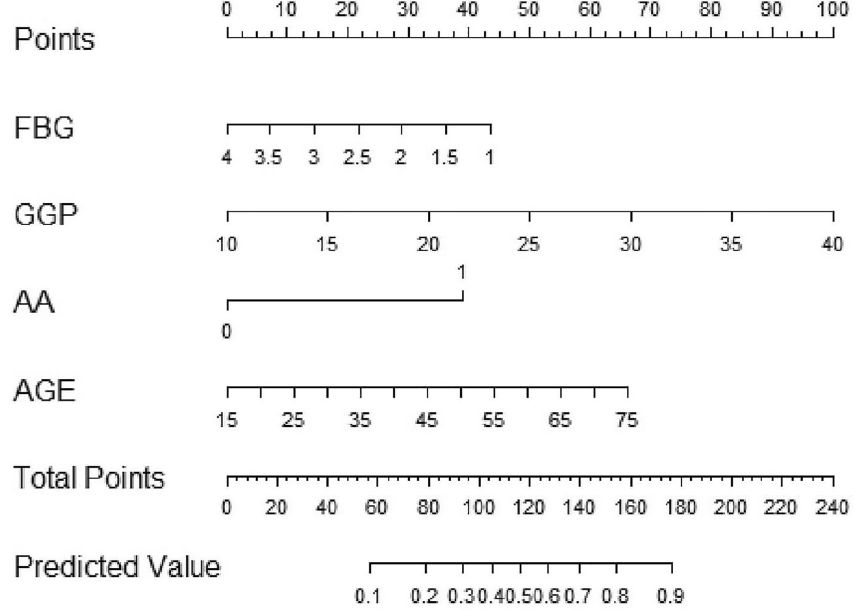
Figure 1. Nomogram for predicting the risk of AIH based on age, FBG, GGP, and AA. An upward vertical line was drawn from each variable axis to get the points of each variable. Calculating the sum of each variable point, and drawing a downward vertical line from the total points axis to obtain the risk of AIH. Example of use: A 50-year-old female is positive for AA with a FBG level of 3.2 g/L and a GGP of 22.5%. The corresponding points of age, FBG, GGP and AA are 40, 13, 42, and 38 respectively, with total points of 133, and the risk of AIH was about 0.64. GGP Percentage of gamma globulin, FBG fibrinogen, AA AIH-related autoantibodies, AIH autoimmune